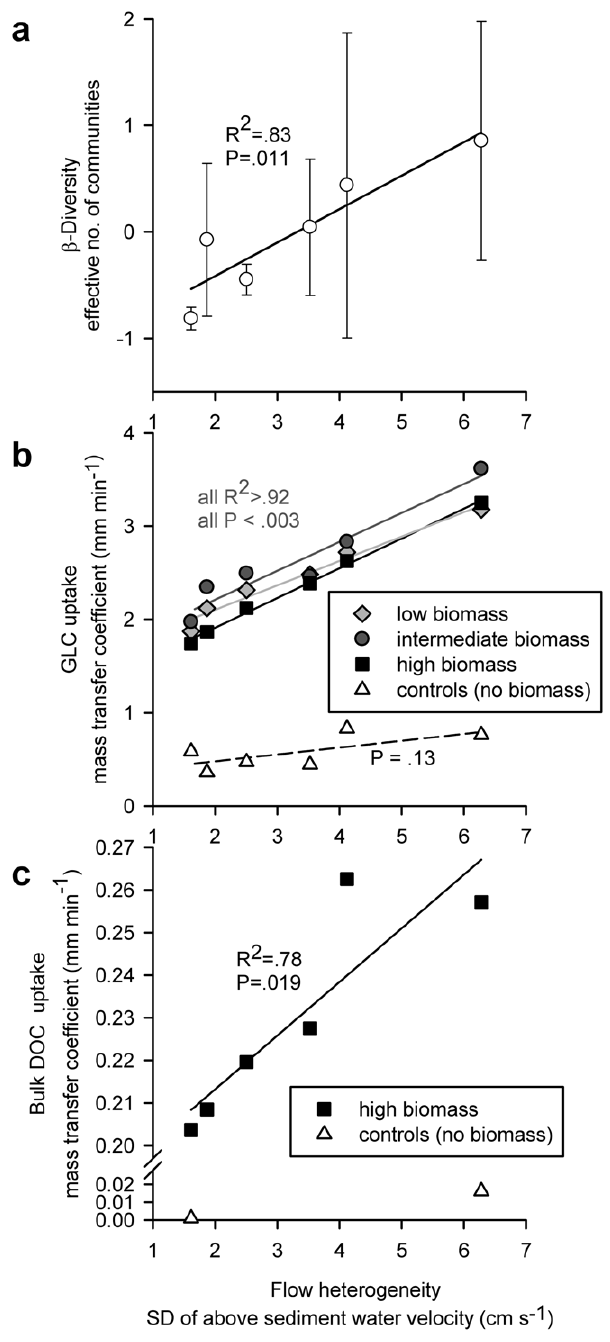
Figure 4. Relationship between flow heterogeneity and bacterial biodiversity and carbon mass transfer. The standard deviation of R xyz (i.e. the length of the 3-dimensional vector of velocity) explains ( a ) b-diversity, as the effective number of communities using an Hill exponent q=1 (data pooled from multiple sampling dates and z- standardised, sample size n=4 per flume on each of 4 dates); ( b ) glucose mass transfer coefficients at various biofilm growth states; and ( c ) bulk DOC mass transfer coefficients. Triangles indicate controls with no biofilms in (b) and (c).